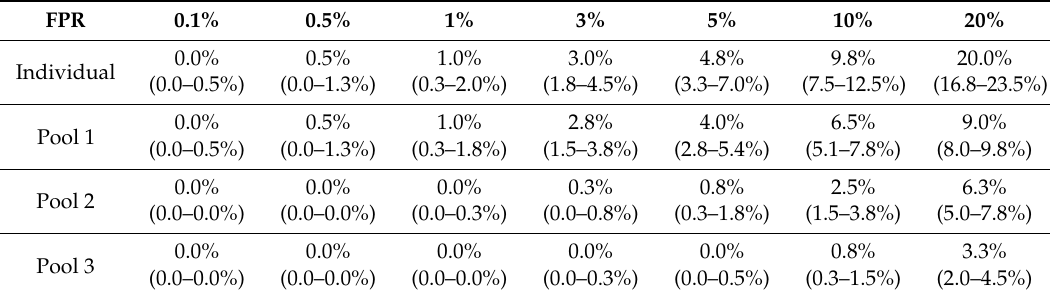
Figure 1. Distribution of signals detected by anti-SARS-CoV-2 NP ELISA in Pre-COVID-19 individual sera in positive pooled samples. Index value, Signal to cut-off (S/C) ratios are plotted. Table 2. Mote Carlo simulation of false positives in pooled samples with di ff erent false positive rates (FPR) and detection